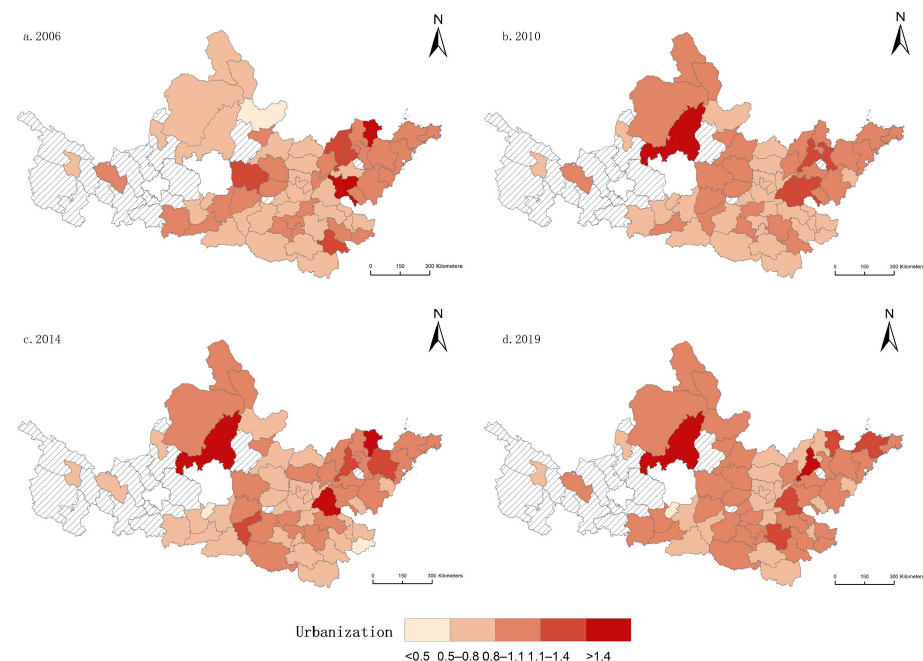
Figure 3. Spatial patterns of urbanization efficiency in ( a ) 2006, ( b ) 2010, ( c ) 2014, and ( d ) 2019 in the Yellow River basin, China.